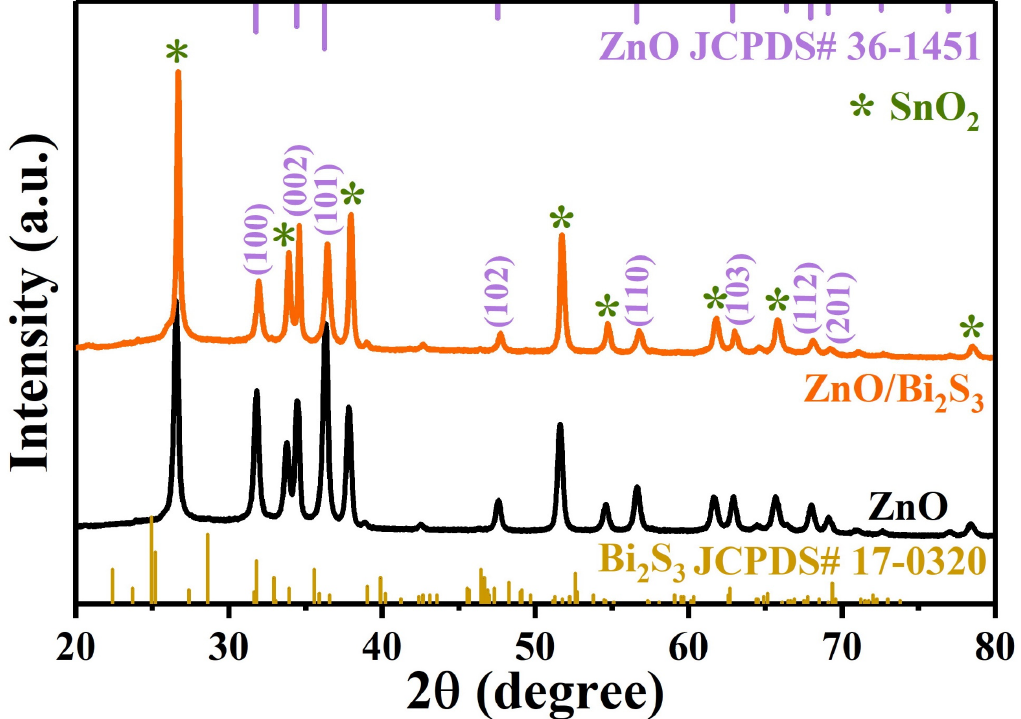
Figure 1. Powder XRD patterns of ZnO and ZnO/Bi 2 S 3 photoanodes.